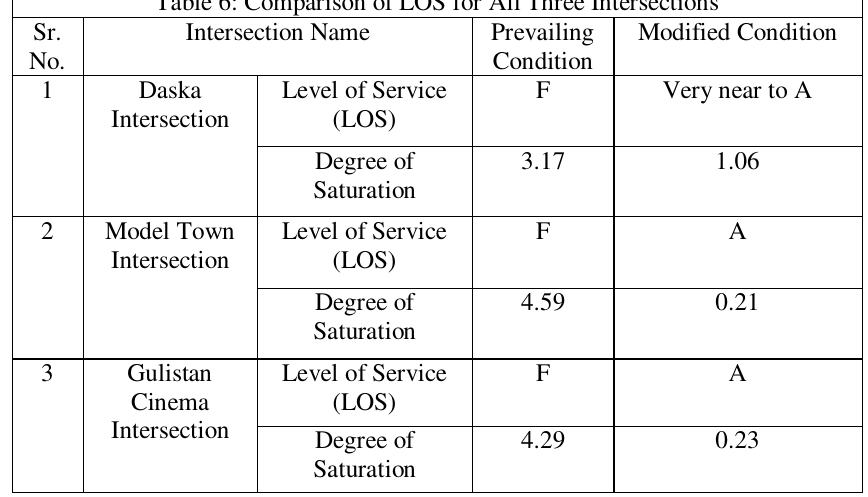
Table 6: Comparison of LOS for All Three